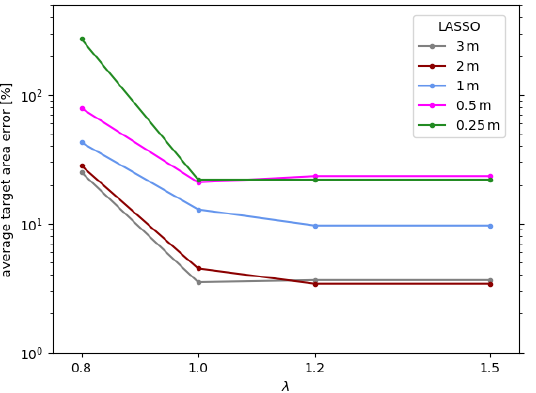
Figure 17. Effect of (cid:96) 1 -norm upper limit λ on LASSO area estimation results. The unsigned rela- ˆ A tive error t − A t | / A t is shown averaged over target materials and separately for the different | target sizes.